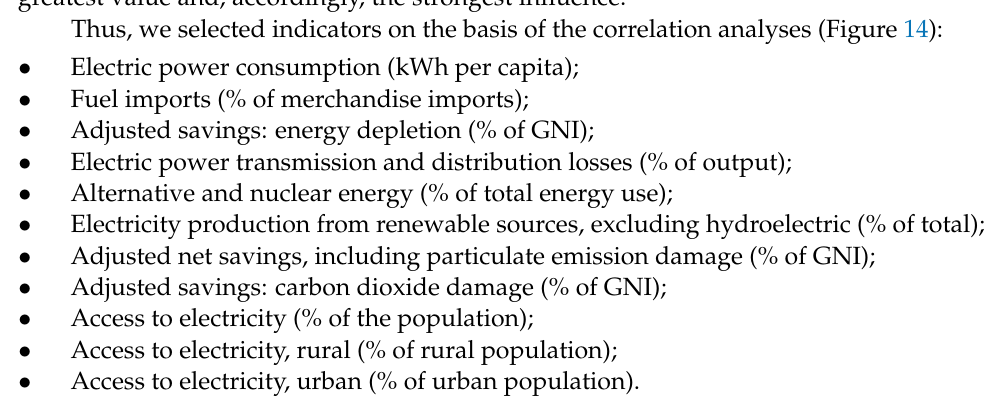
Figure 12. Dynamics of structural components of the economic security of Ukraine.